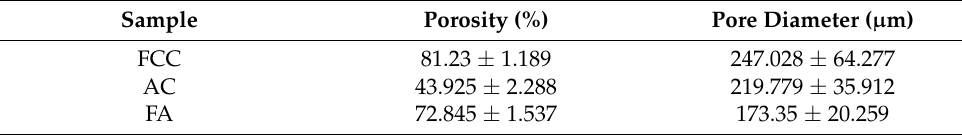
Figure 1. Gross observation and SEM images of different scaffolds. ( a )FCC, ( b )AC, and ( c )FA. Scale bars = 200 μm. The freezing temperature of each sample was – 20 °C. Table 1. Results of porosity and pore size of different